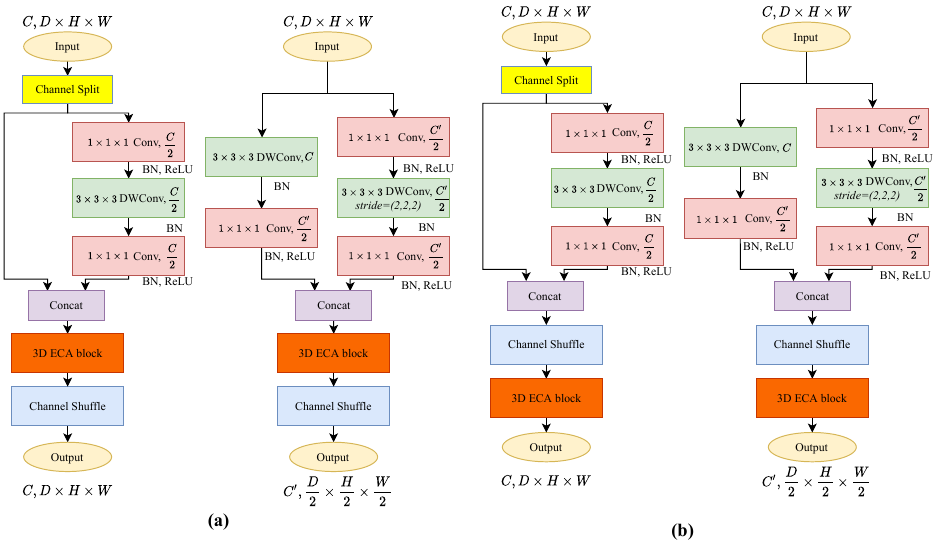
Figure A1. We built ECA block both before and after channel shuffle operation to find a more appropriate architecture of 3D ECA-ShuffleNetV2. ( a ) before channel shuffle operation. ( b ) after channel shuffle operation.